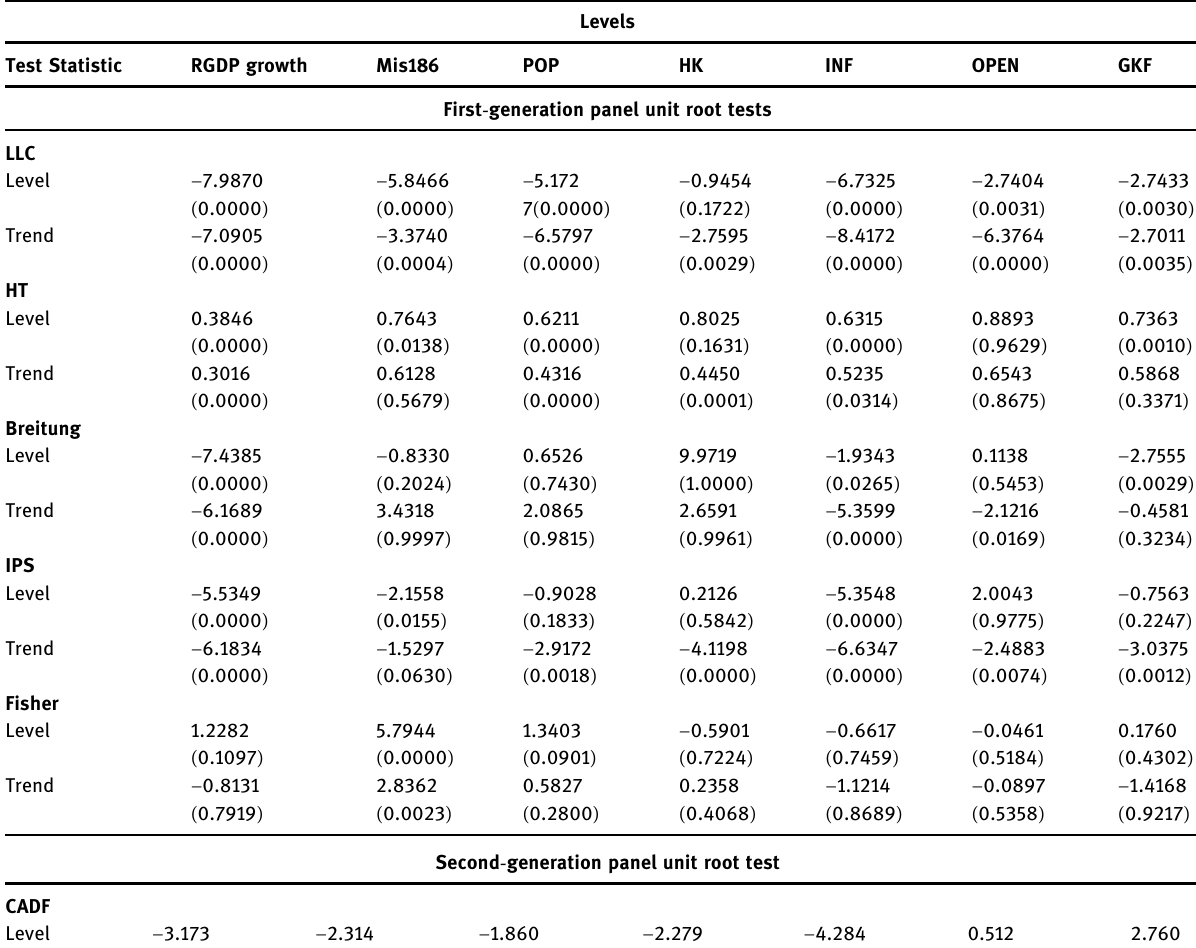
Table 1: Panel unit roots results ( fi rst and second panel unit root tests